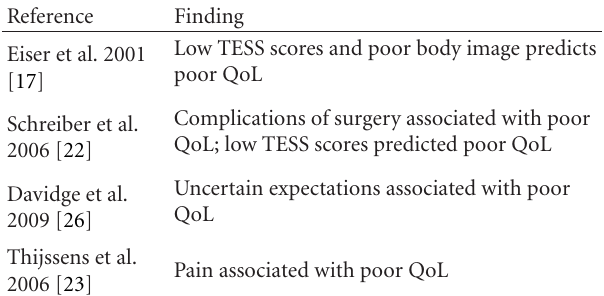
Table 5: Studies that correlated variables with overall